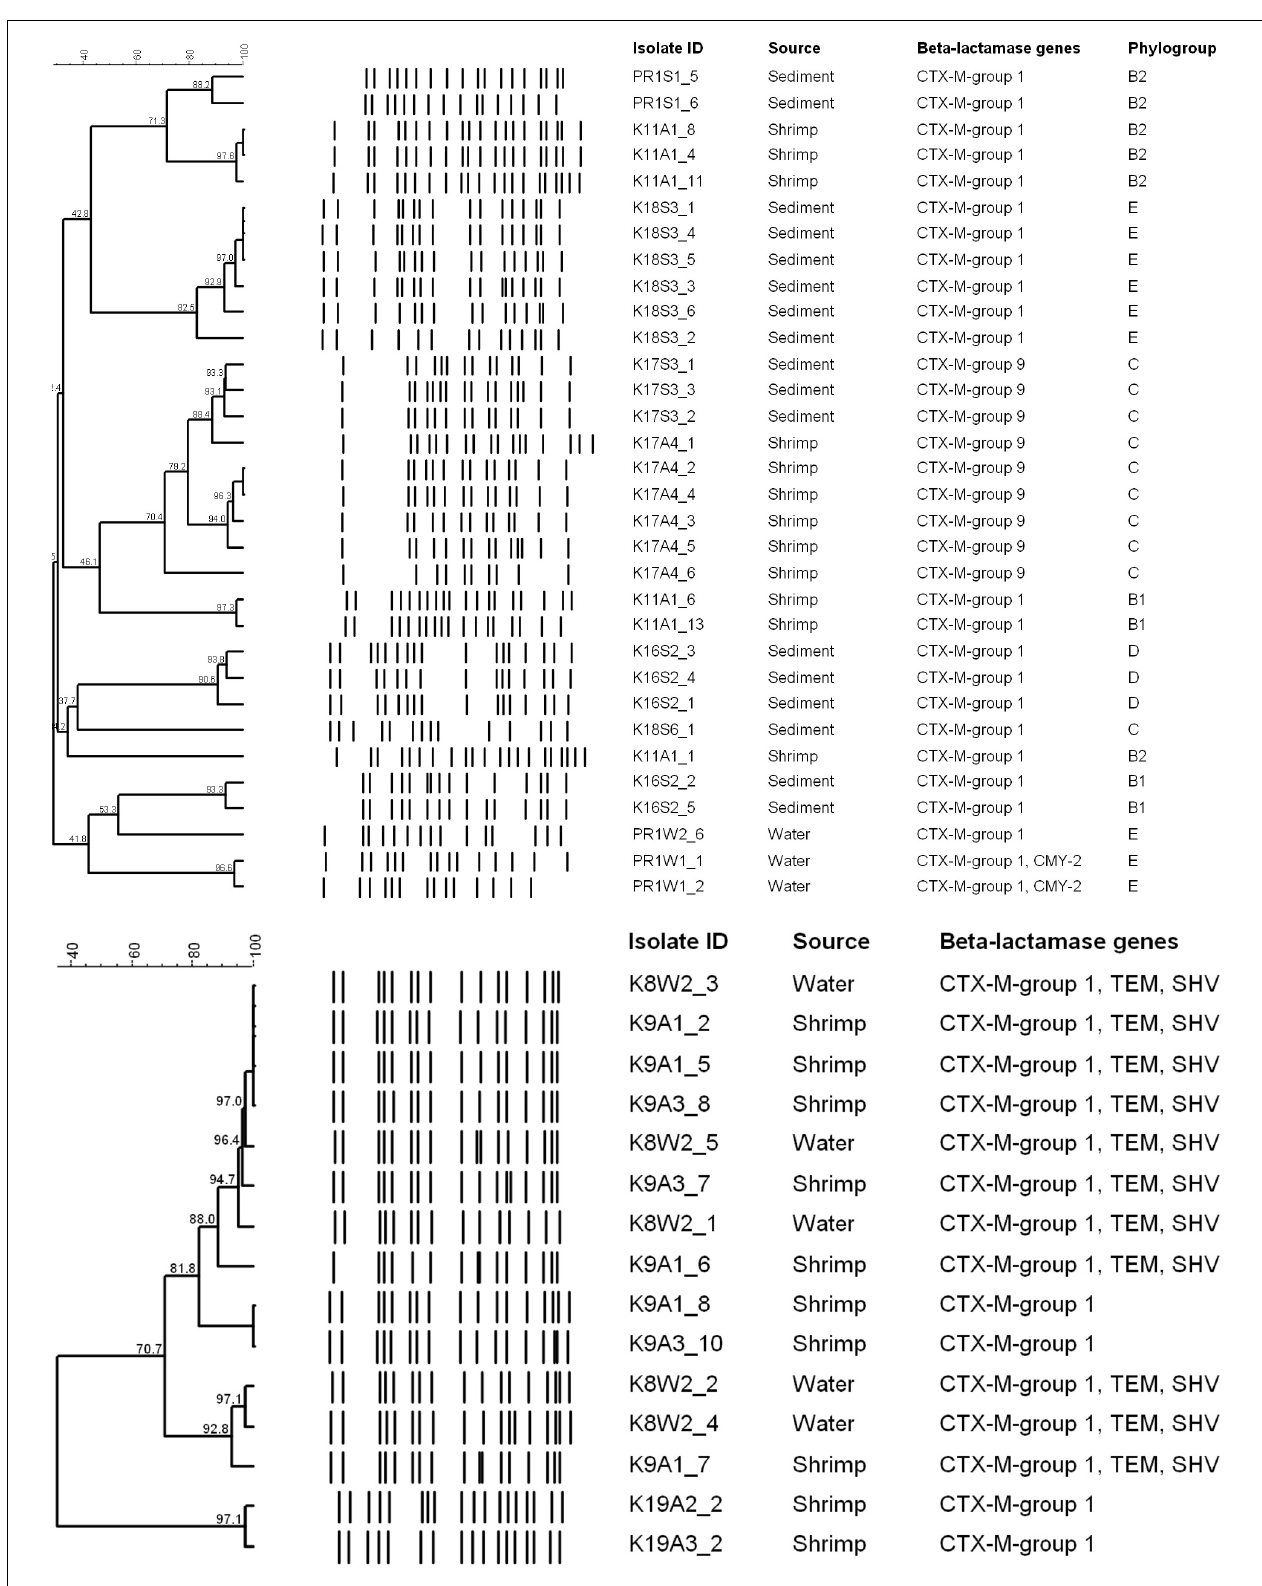
FIGURE 4 | Dendrograms showing cluster analyses of Xba1 -PFGE patterns of the ESBL-producing E. coli (top) and K. pneumoniae (below) isolates.